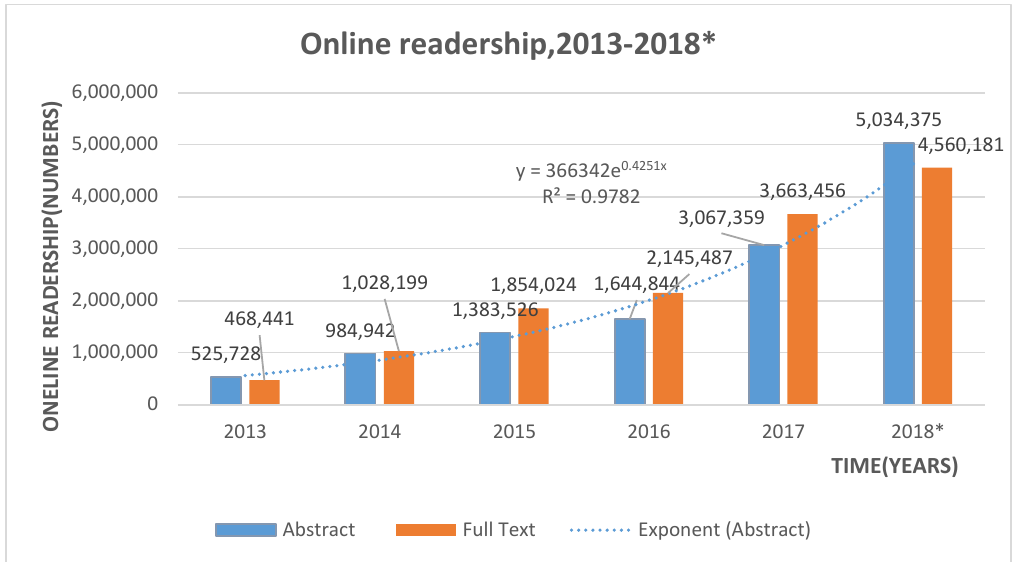
Figure 4. CiteScore, another measure of impact of the journals developed by the publisher Elsevier.